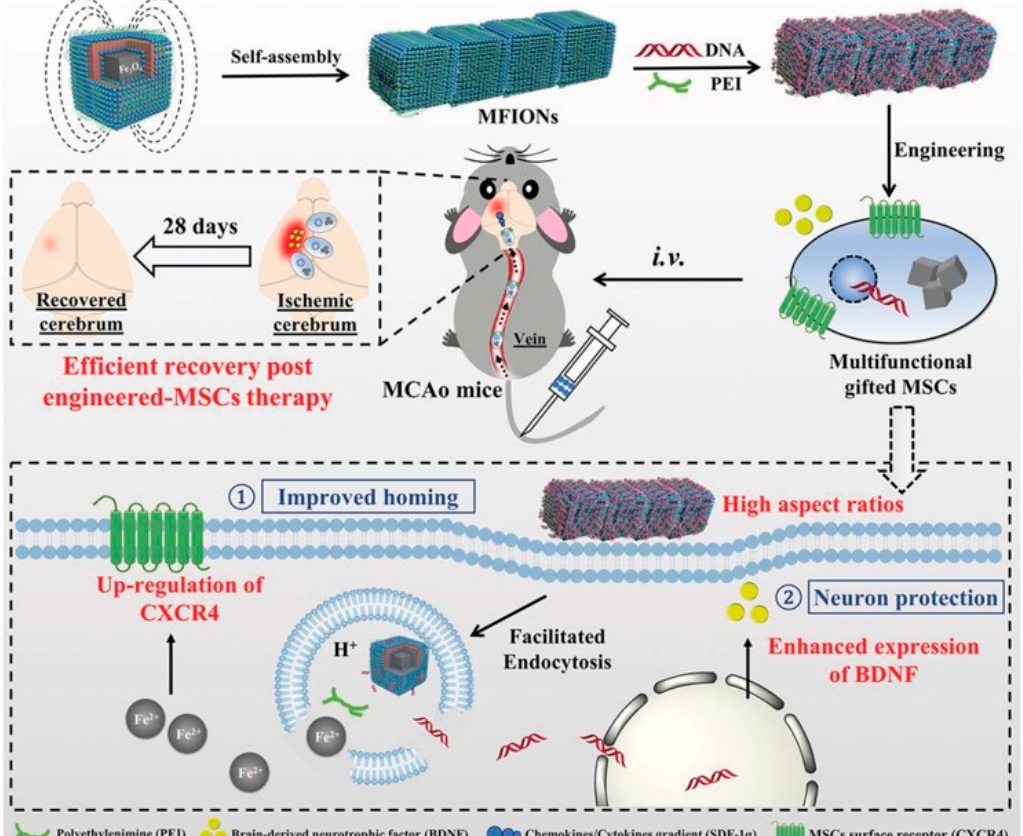
Figure 11. Schematic illustration of ferrimagnetic nanochain assembly, their surface modification, transfection of mesenchymal stem cells, and in vivo application to trigger post-stroke recovery in a mouse model. Reproduced with permission from [26], Copyright 2019, with permission from Wiley.